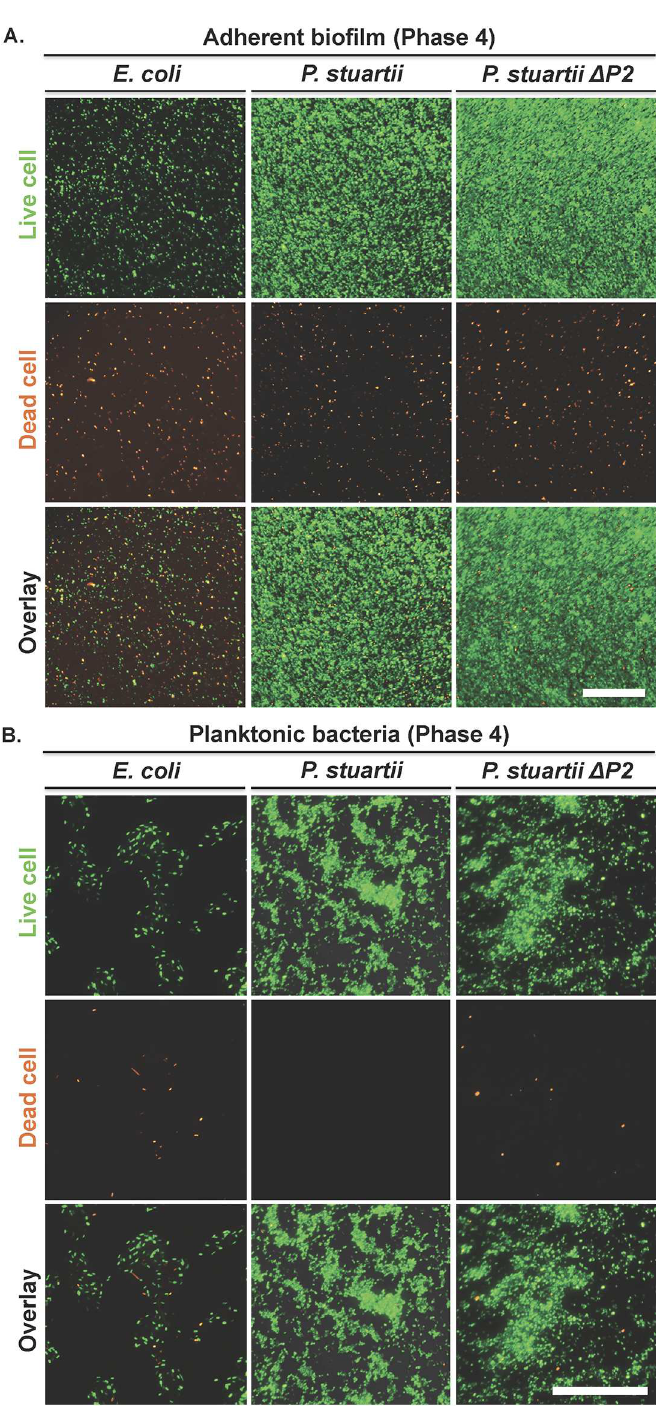
Fig 3. P . stuartii is adept at forming large biofilms mainly composed of living cells. (A) Micrographs of bacteriaadherentto the wells surface after discardof planktoniccells by PBS washes. (B) Micrographs of planktonic bacteria. Cells were pipetted from the LB medium, spreaded on LB-Gelzan ® and imaged immediatly. Live and dead cells were stainedwith SYTO9 Green and propidiumiodide, respectively.Scale bars are 100 and 50 μ m in panels(A) and (B),